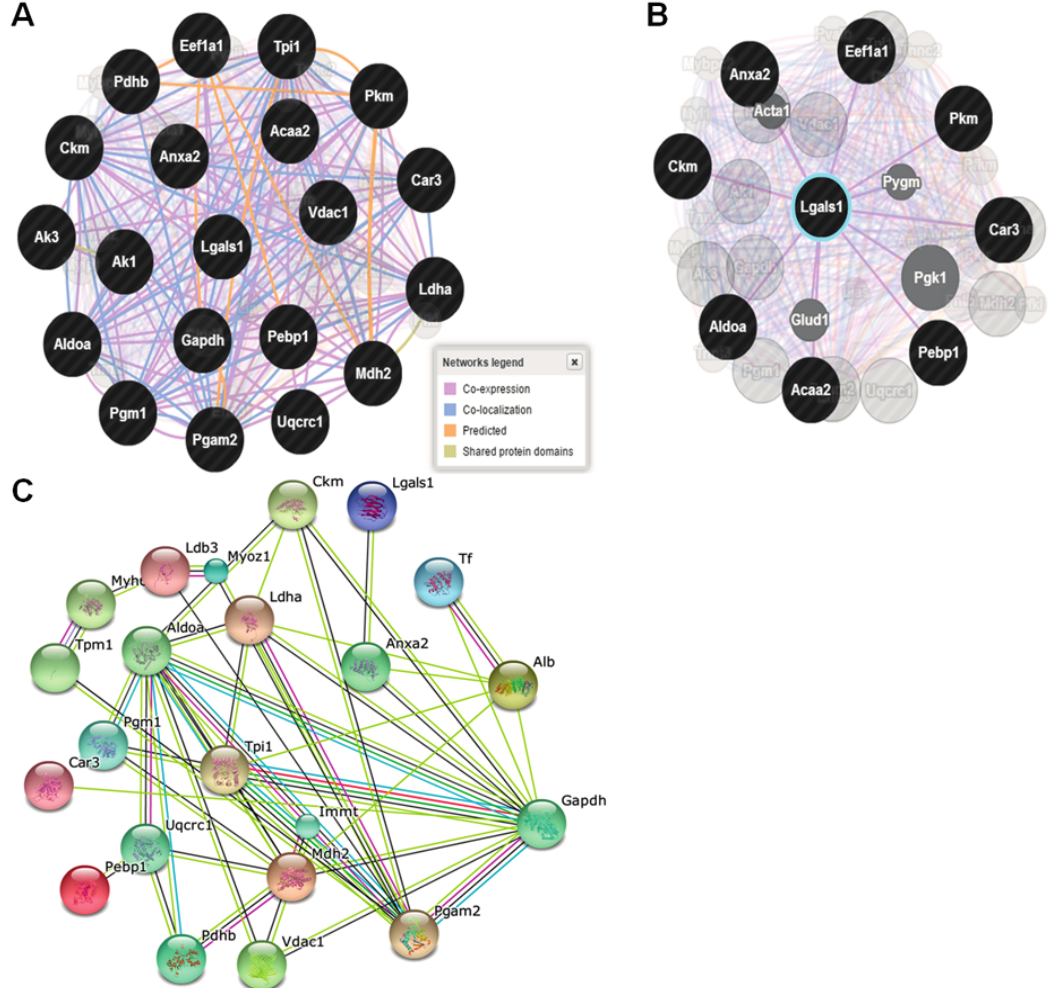
Figure 7. GeneMANIA and STRING, showing interaction patterns of differentially regulated proteins identified from proteomic study. Prediction results of gene interactions using GeneMANIA, which focuses on differentially expressed proteins mostly involved in metabolic and signaling pathways (in black circle), as well as a close-up screenshot of only those query genes directly linked with target protein (galectin-1, GAL1) captured with all other interactions hidden ( A , B ); Prediction of protein interactions between GAL1 and other differentially expressed proteins ( C